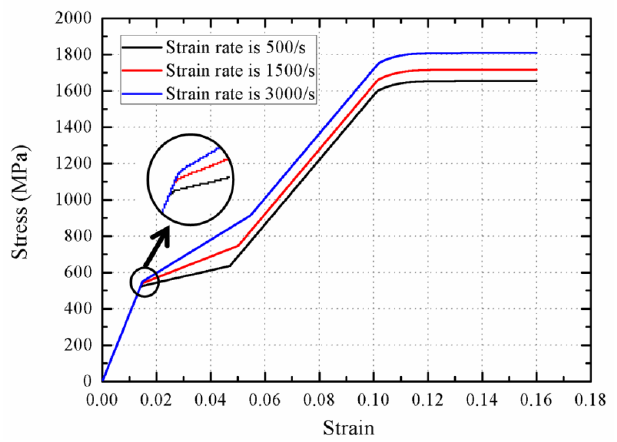
Figure 16. The stress – strain response with various strain rates.